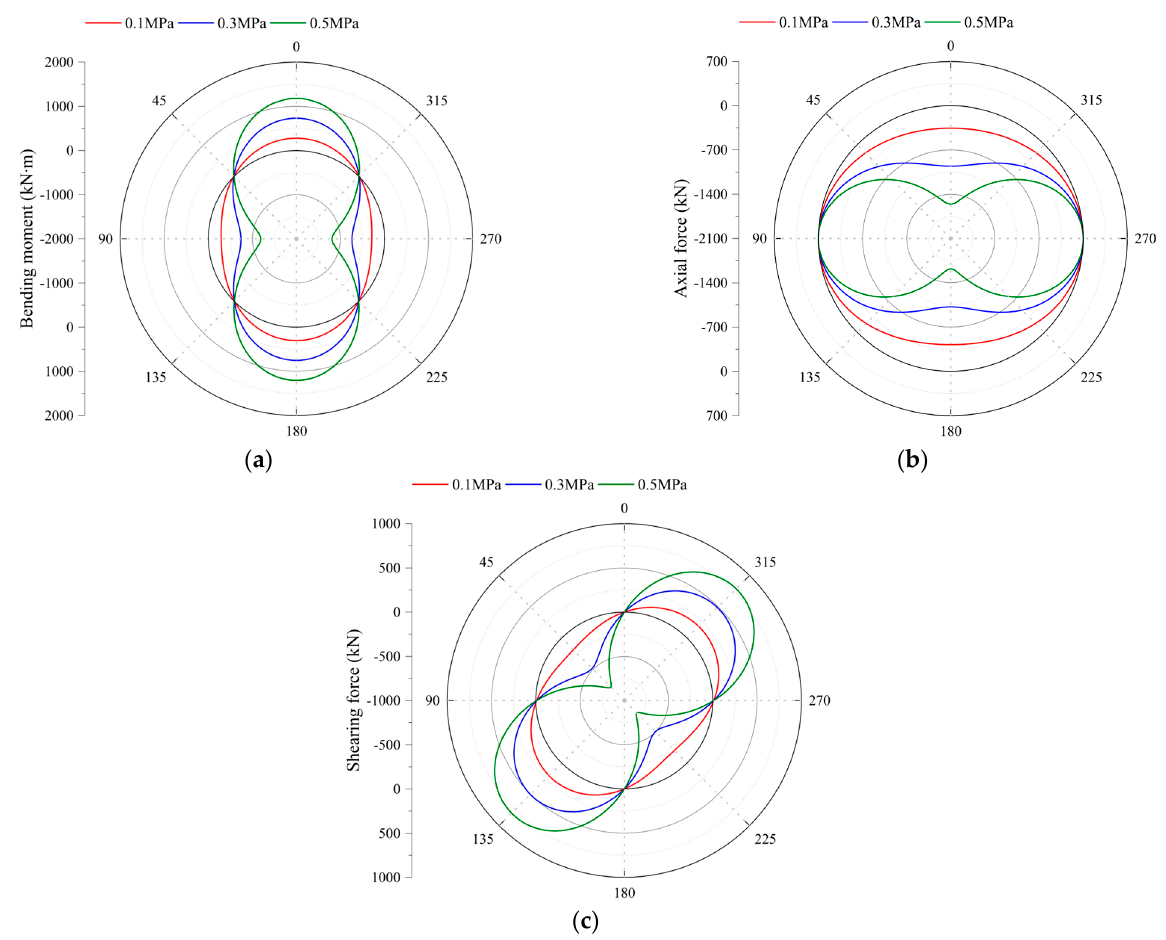
Figure 8. Influence of pressurized water conveyance pressure on internal force distribution of lining. ( a ) Bending moment distribution diagram. ( b ) Axial force distribution diagram. ( c ) Shear force distribution diagram.